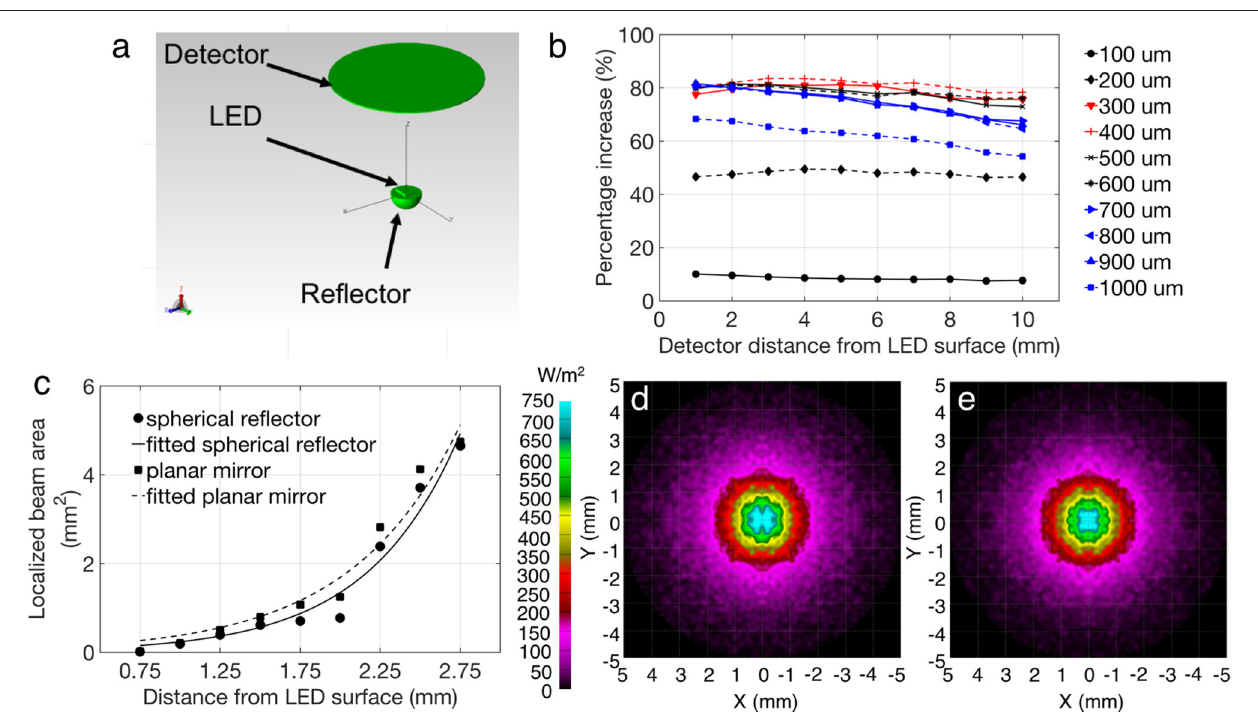
FIGURE 3 | (a) Simulation model in TracePro. (b) Simulation showing the optical intensity enhancement of the reflector-coupled device, as compared with a bare LED (without any reflector). Legend refers to cavity diameter. (c) Focused beam areas using planar and spherical reflectors with fitted curves, calculated at various distances from the LED surface (d,e) example of beam localization between a planar mirror and spherical reflector, respectively at 1.5mm from the LED surface, colormap is the same for both (d,e)